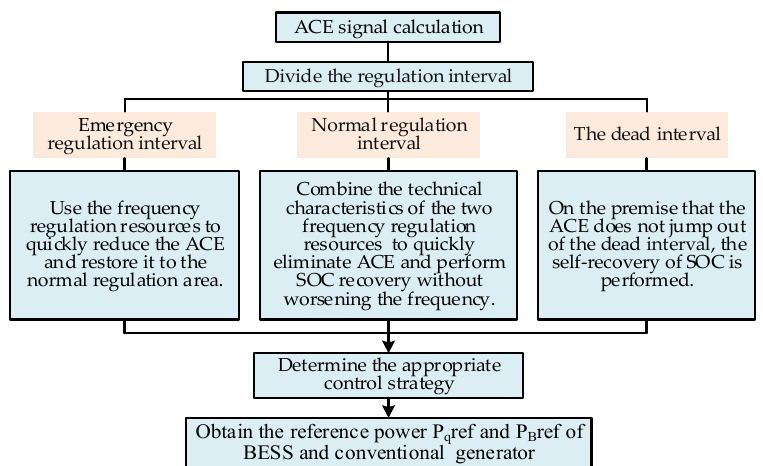
Figure 3. Regional dispatch layer frequency regulation control structure.